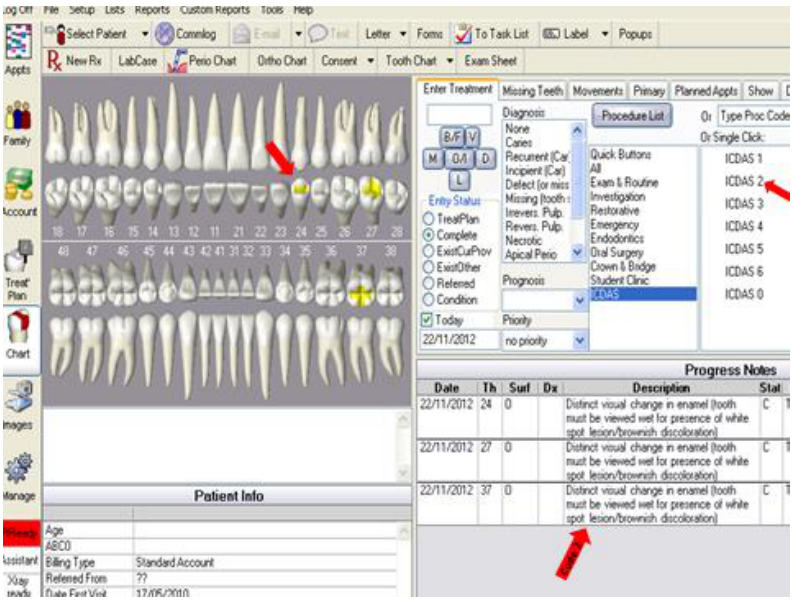
Figure 7. Modification of electronic system of clinical